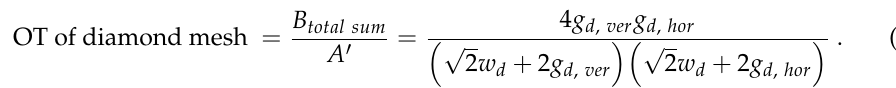
Figure 1. Structure of the mesh pattern for schematic representation and OT: ( a ) square mesh; ( b ) diamond mesh.